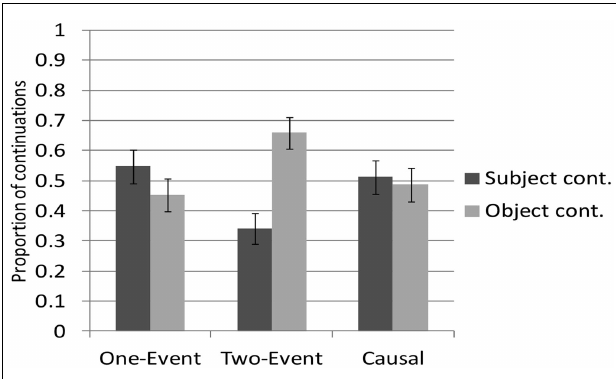
FIGURE 3 | Proportion of continuations that start by referring to the preceding subject or the preceding object, as a function of prime type. (Error bars show ± 1